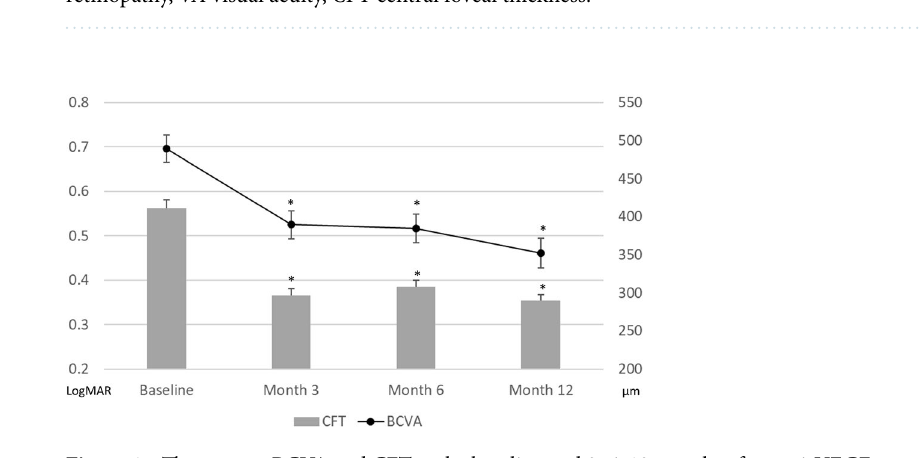
Table 1. Demographic data at the baseline of the patients who received anti-vascular endothelial growth factor treatment for diabetic macular oedema. HbA1C haemoglobin A1C, PDR proliferative diabetic retinopathy, VA visual acuity, CFT central foveal thickness.